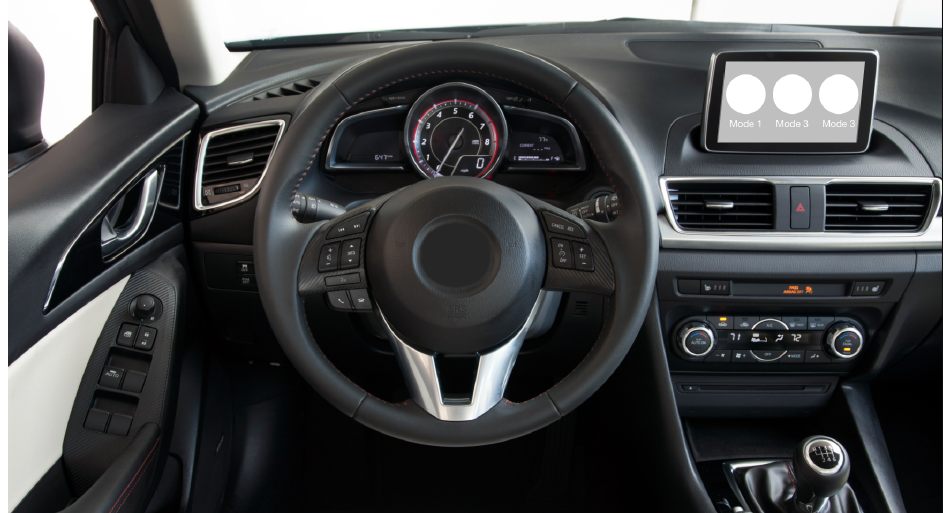
Figure 2. SSVEP-based driving mode selection system: a view of the car dashboard and the SSVEP interface in the